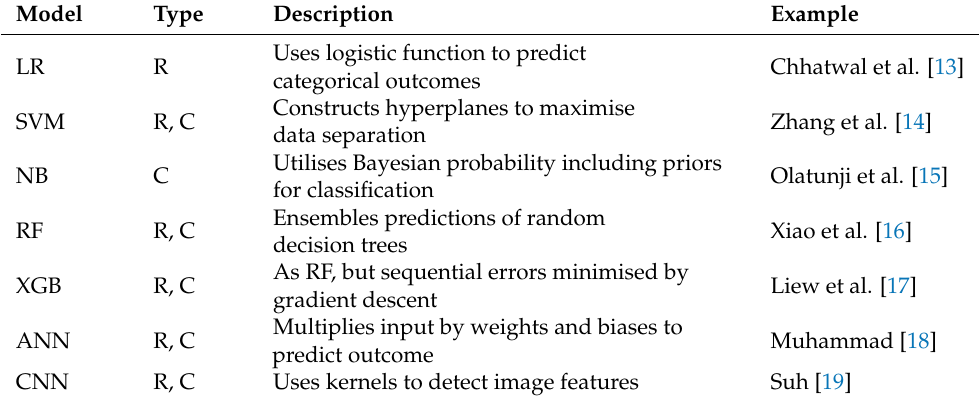
Table 1. Common supervised ML techniques with early diagnosis